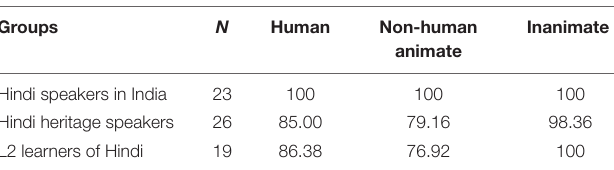
TABLE 6 | Elicited Production Task.